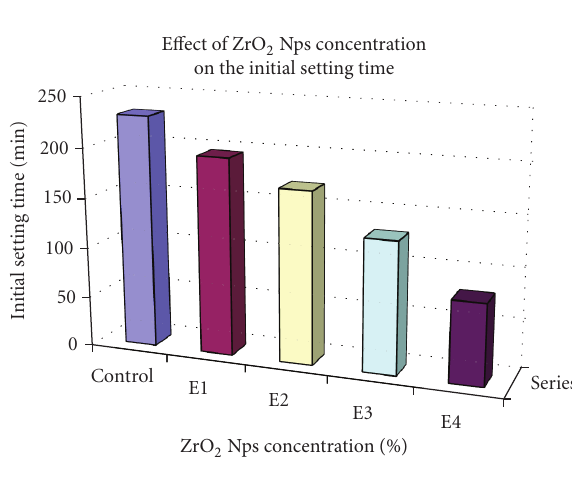
F 4: Initial setting time of cement modi�ed with ZrO